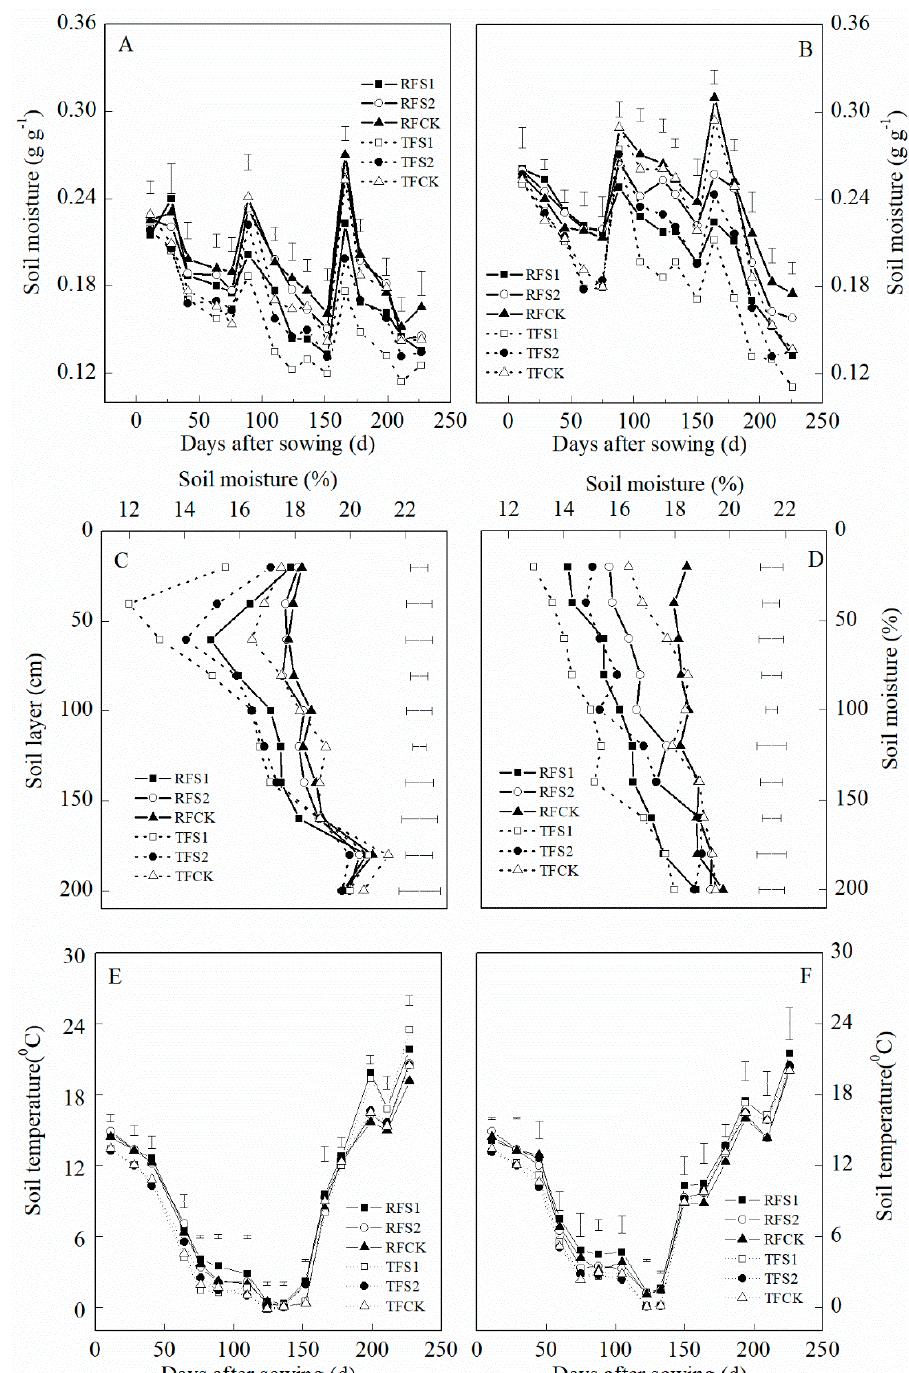
Figure 3. Effects of planting method and irrigation on the soil moisture and soil temperature. ( A , B ): soil moisture of 0–20 cm soil layer during the growing period of wheat in 2016–2017 and 2017–2018, respectively. ( C , D ): soil moisture of 0–200 cm soil layer at maturity in 2016–2017 and 2017–2018, respectively. ( E , F ): soil temperature of 5 cm soil layer during the wheat growth period in 2016–2017 and 2017–2018, respectively. RF: plastic-covered ridge and furrow planting; TF: traditional flatten planting; S1: supplemental irrigation based on measuring soil moisture and the target relative soil water content is 85%; S2: supplemental irrigation based on measuring soil moisture and the target relative soil water content is 100%; CK: traditional irrigation. Horizontal bars represent the honestly significant difference at p = 0.05.